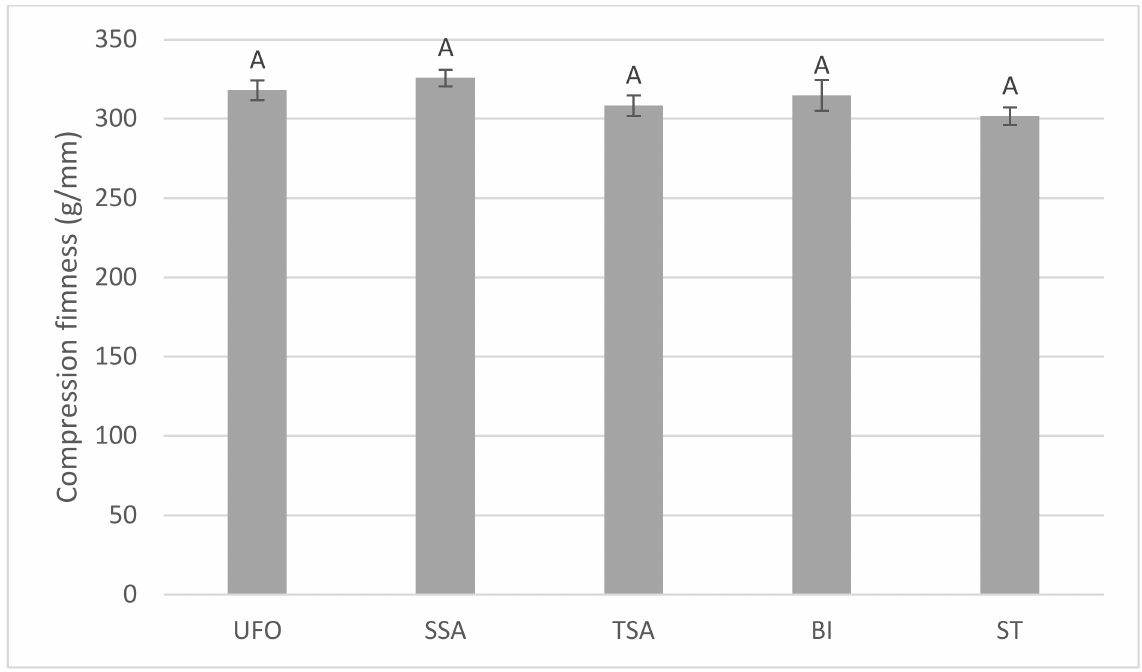
Figure A3. Average fruit compression firmness of sweet cherry cultivar ‘Kordia’ in different training systems and seasons. Different letters above the means indicate significant difference ( p ≤ 0.05) between training